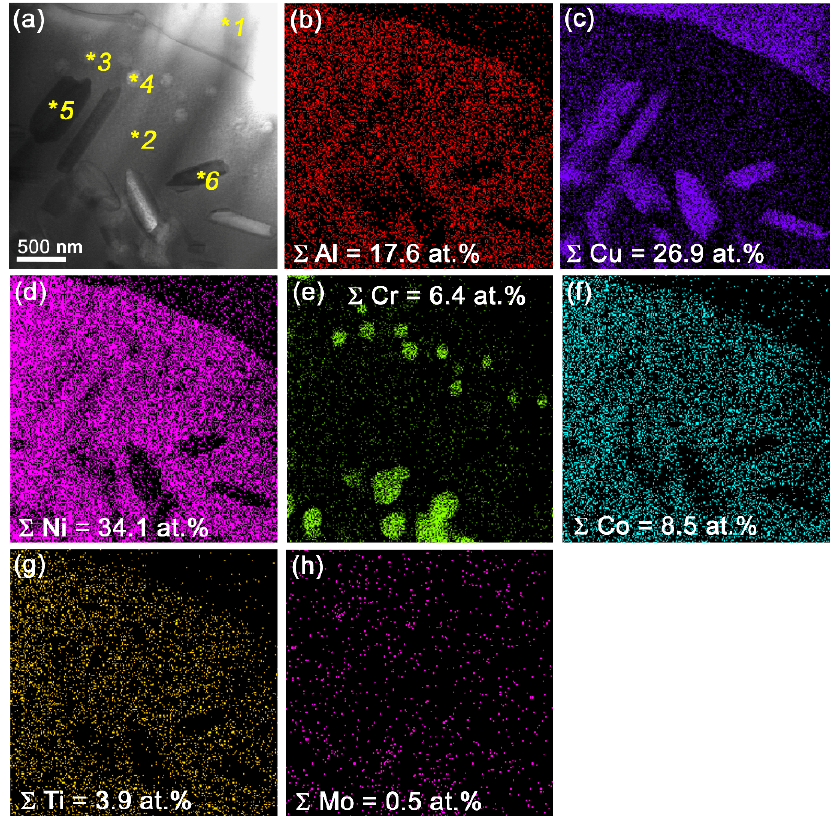
Figure 11. Bright-field TEM image of a NiAl grain in 25% Ud composite ( a ) with EDS element distribution maps ( b – h ) showing the presence of Cu-rich ( c ) and Cr-rich ( e ) particles. EDS element concentrations in zone 1 to 6 in ( a ). Table 3. EDS element concentrations in points indicated on the 25% Ud sample (Figure